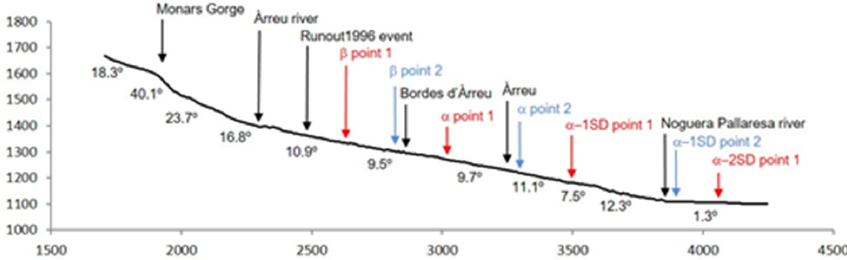
Figure 17. Detail of the topographic profile of the track and runout zones of Monars avalanche path, from Monars gorge to Noguera Pallaresa river, showing the α and β points positions.